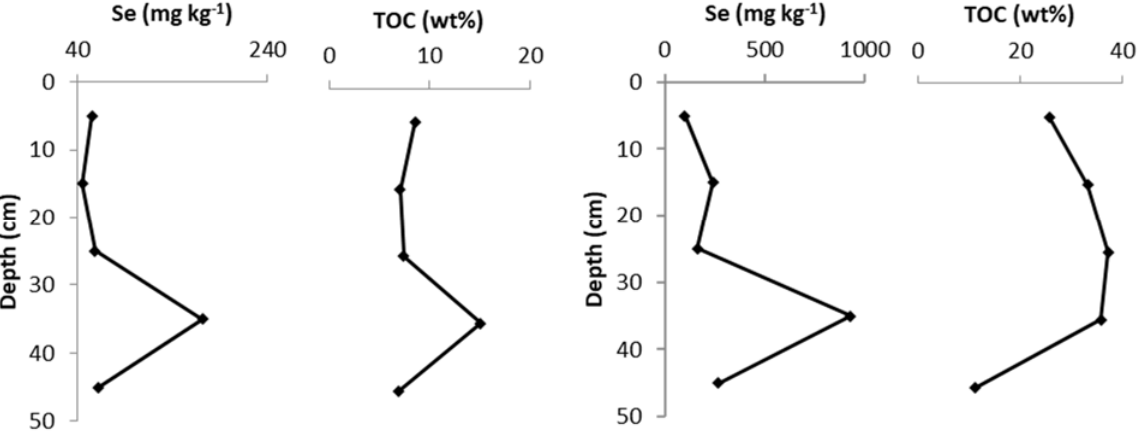
Figure 4. Se and total organic carbon (TOC) values measured in vertical cores at site TL-C1 ( left ) and site FF-C2 ( right